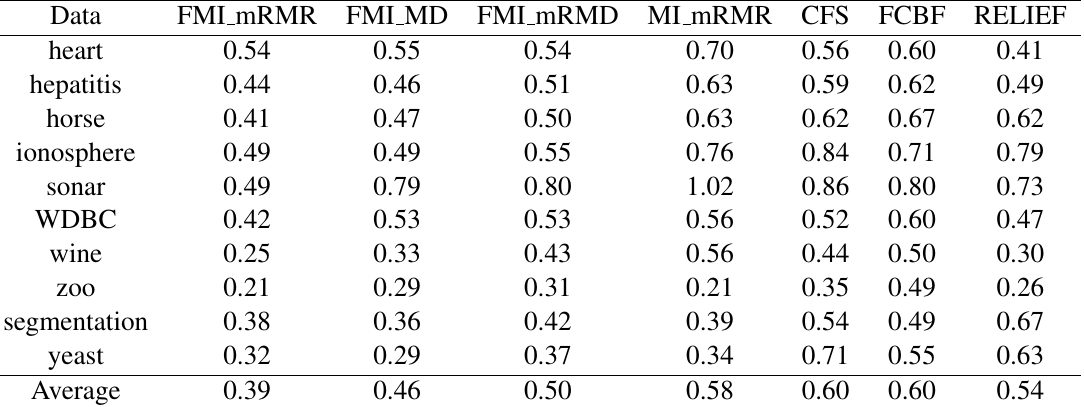
Table 5: Stability of feature